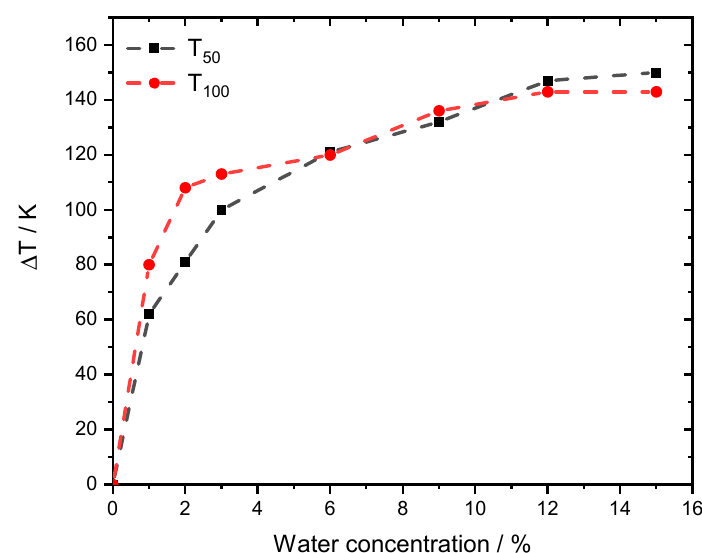
Figure 2. ∆ T 50 and ∆ T 100 for di ff erent light-o ff measurements for PdO / Al 2 O 3 in 3200 ppm CH 4 , 10% O 2 and balance N 2 in the absence of steam and in the presence of di ff erent water concentrations, Figure 2. Δ T 50 and Δ T 100 for different light-off measurements for PdO/Al 2 O 3 in 3200 ppm CH 4 , 10% O 2 with a temperature ramp of 3 K min − 1 . GHSV = 140,000 h − 1 and balance N 2 in the absence of steam and in the presence of different water concentrations, with a temperature ramp of 3 K min − 1 . GHSV = 140,000 h − 1 .